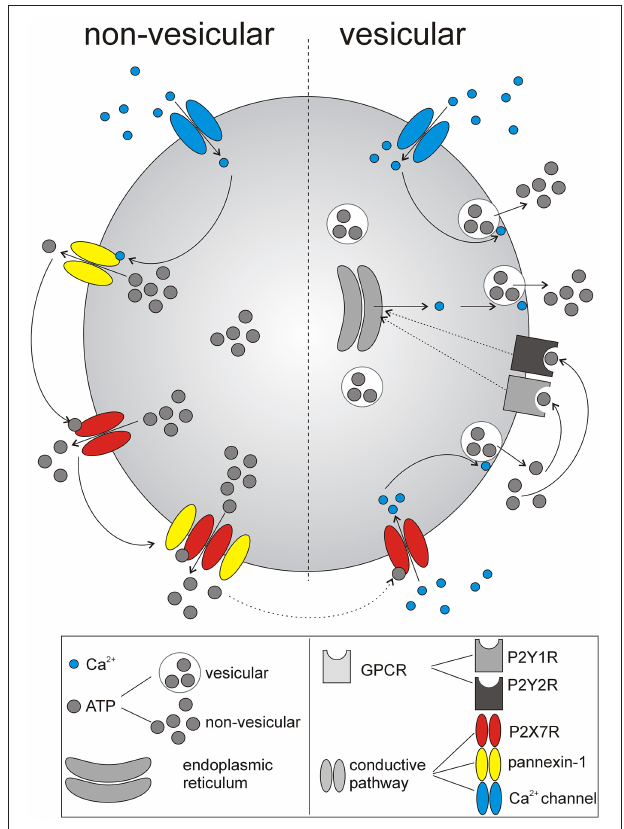
FIGURE 8 | Schematic summary of identified mechanism underlying ATP release from SCN astrocytes. The initial non-vesicular release (predominantly Ca 2 + -independent) of ATP from astrocytes in the SCN is potentially associated with P2X7R and pannexin-1 hemichannel activation. Released ATP further stimulates P2X7R, and G-protein coupled P2YRs (GPCRs), P2Y1Rs, and P2Y2Rs, that evoke Ca 2 + -dependent, vesicular. release of ATP. Thus, multiple purinergic P2 receptor systems, with the contribution of gap junction channels, control release of ATP from SCN astrocytes.